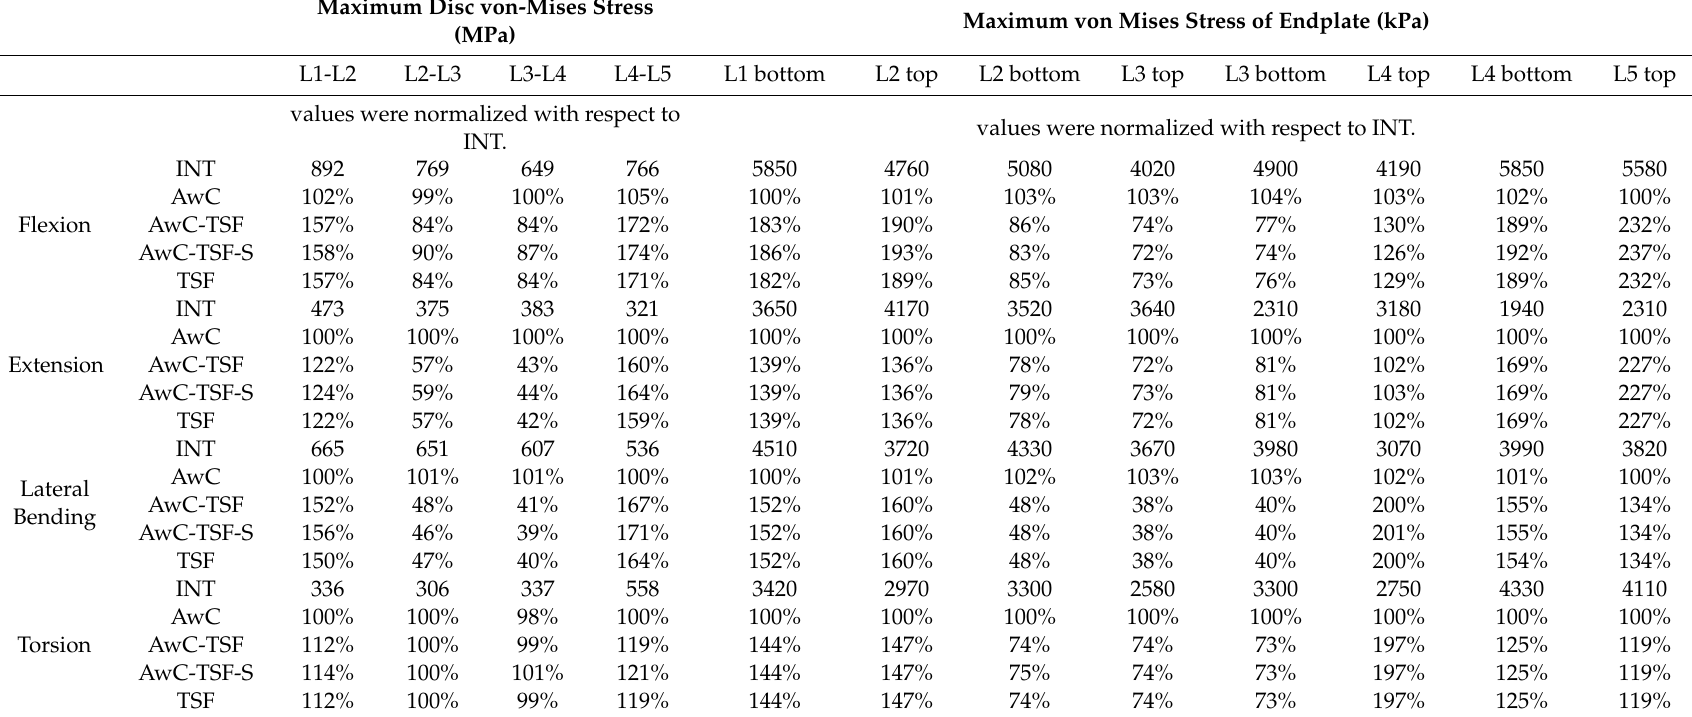
Table 3. Maximum von Mises stress in disc and endplate in five FE